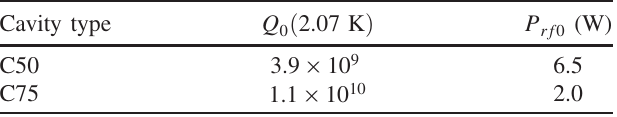
TABLE IV. Computed rf heat load at E and C75 cavities in CM configuration, assuming a combined Q 0 as numerically assessed for flush plunger